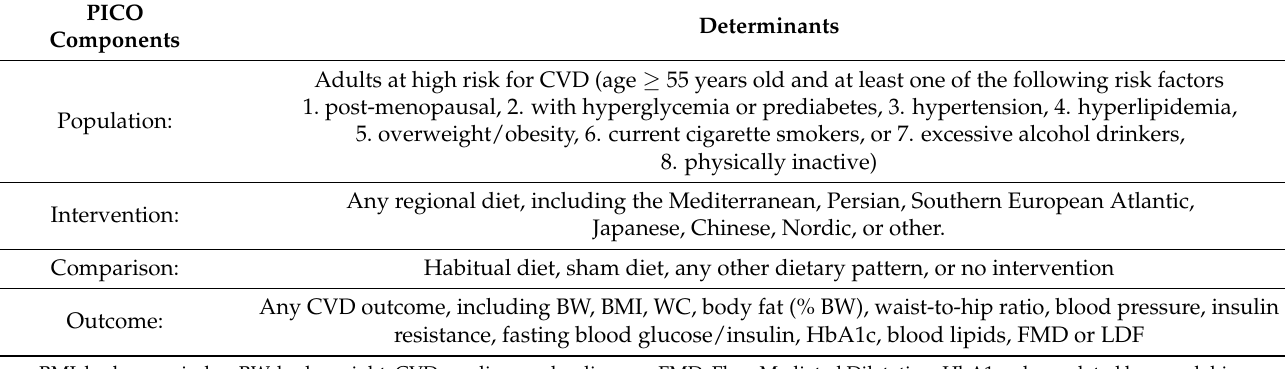
Table 1. PICO of the study’s research question.